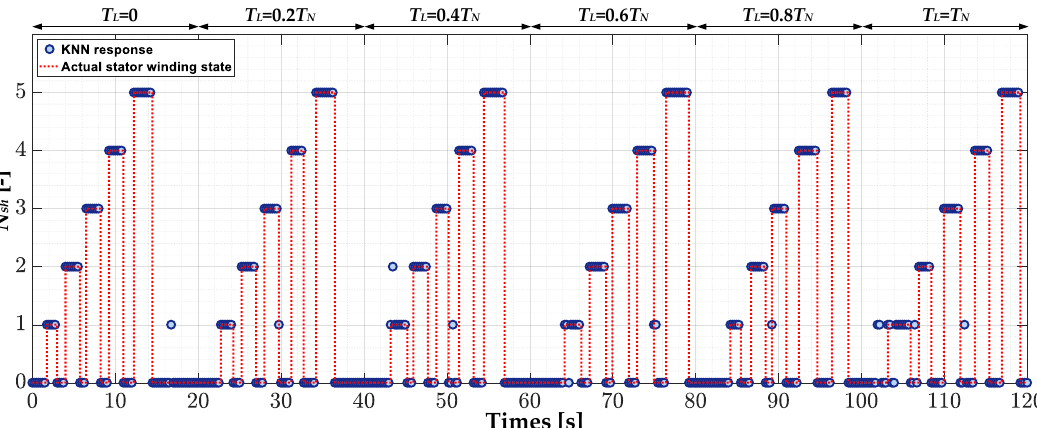
Figure 22. The actual states of the stator windings and KNN model responses of the fault classifier models for on-line operation of the PMSM drive.